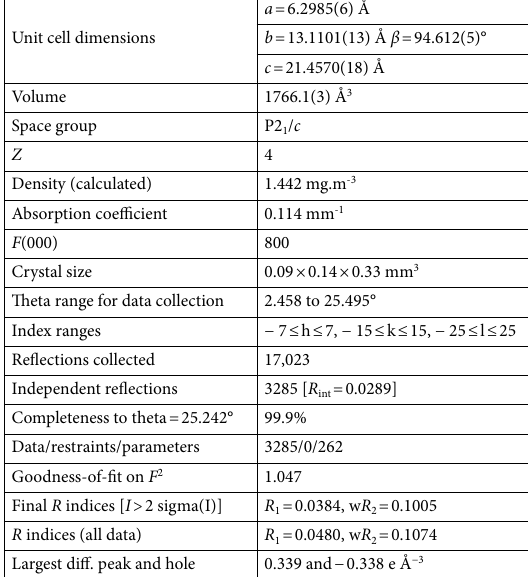
Table 3. Compound 1 crystal data and structure refinement.